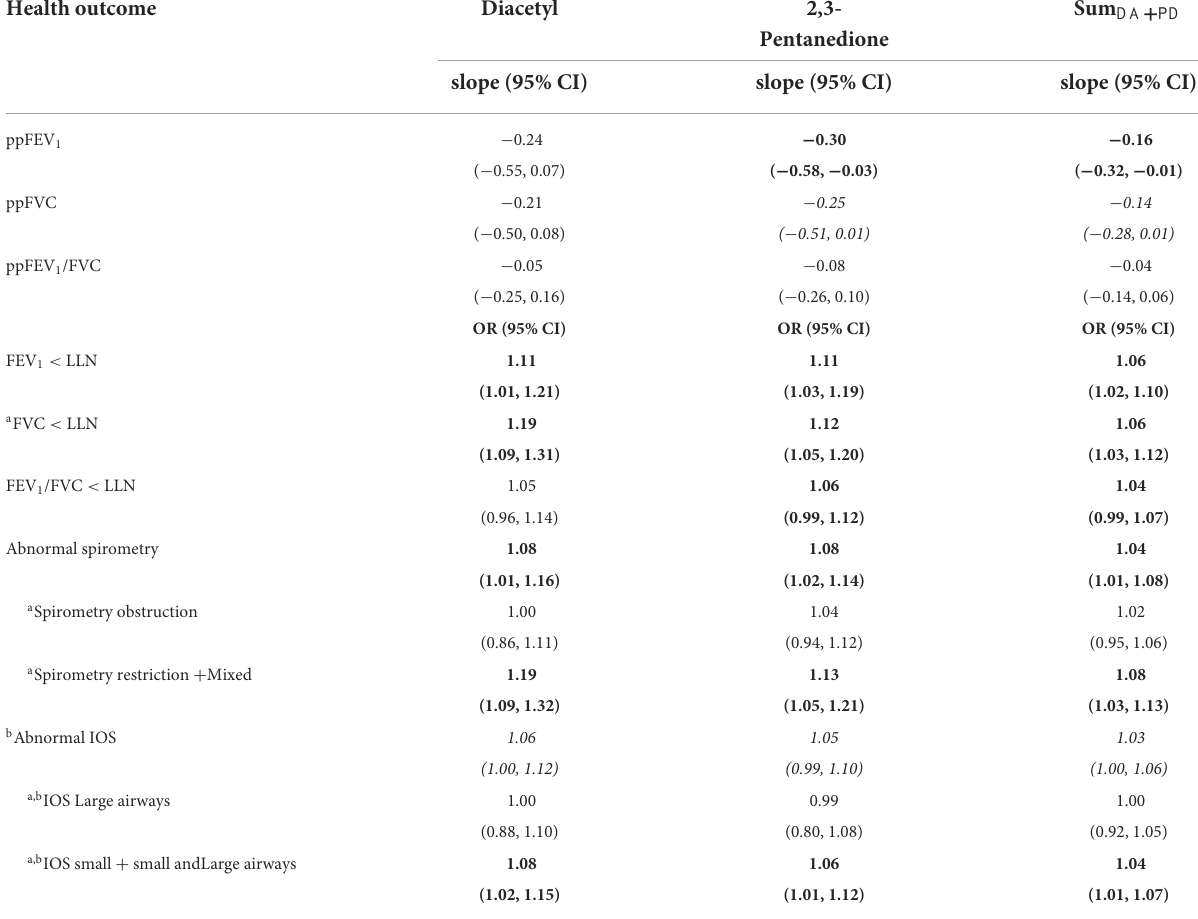
TABLE 2 Associations of lung function with worklife P95 exposure metric for diacetyl, 2,3-pentanedione, and Sum DA+PD . Health outcome Diacetyl 2,3-